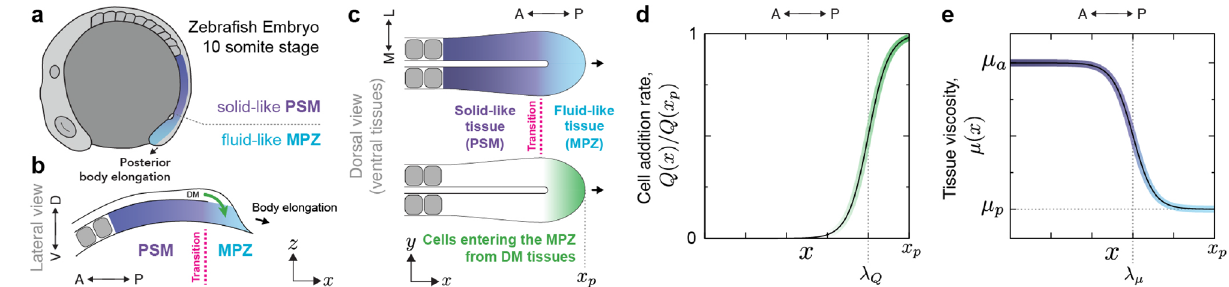
Figure 1. Fluid-to-solid tissue transition during zebrafish posterior axis elongation. ( a ), Schematic lateral view of the zebrafish embryo at 10-somite stage, showing the previously reported 2 fluid-like mesodermal progenitor zone (MPZ) and solid-like presomitic mesoderm (PSM). ( b ), Cells from dorsal-medial (DM) tissues (green arrow) enter the ventral MPZ tissue at the posterior end (lateral view). The tissue undergoes a fluid-to-solid transition along the AP axis, as cells from the fluid-like MPZ mature and join the solid-like PSM. ( c ), Sketch of a dorsal view of ventral tissues showing both the fluid-to-solid tissue transition and the entrance of cells from